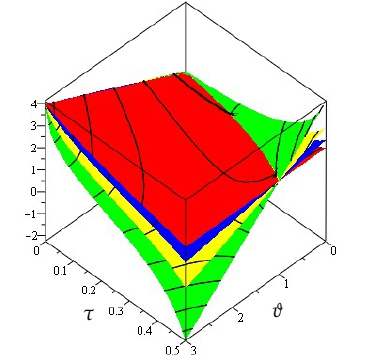
Figure 14. The analytical solutions of ν ( ϑ , ζ , z , τ ) at (cid:36) = 0.6 and 0.4 of Example 4.